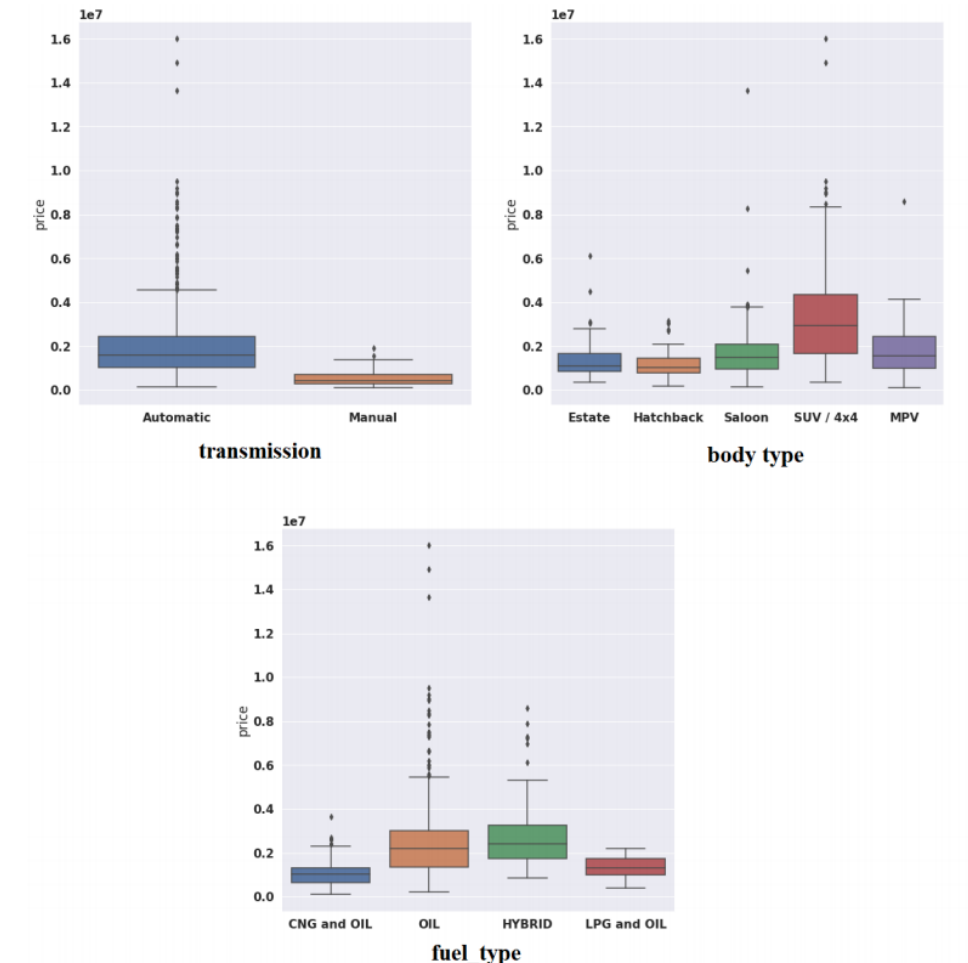
Figure 6. Box plot for transmission , body_type , fuel_type , and model_year features.